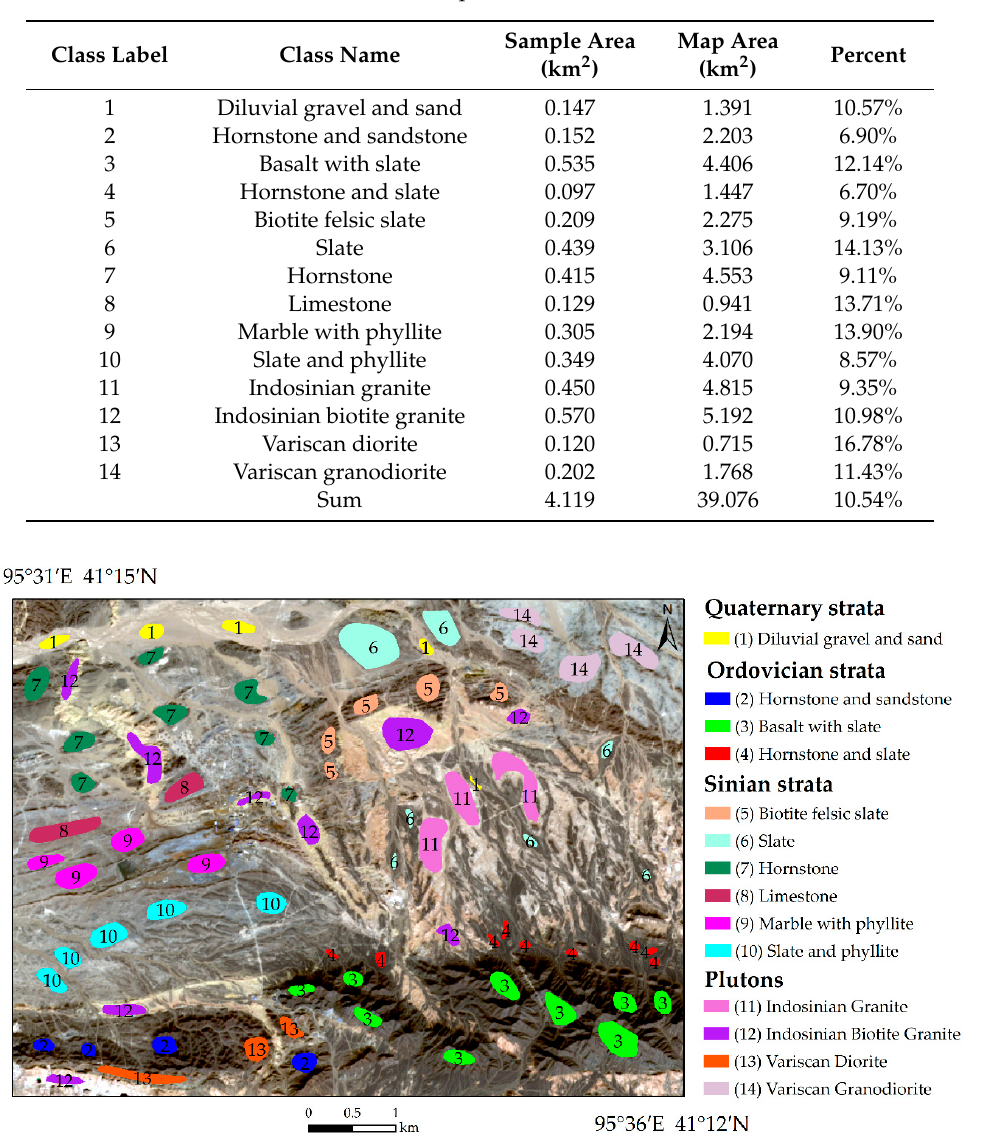
Table 6. Sample size statistics.